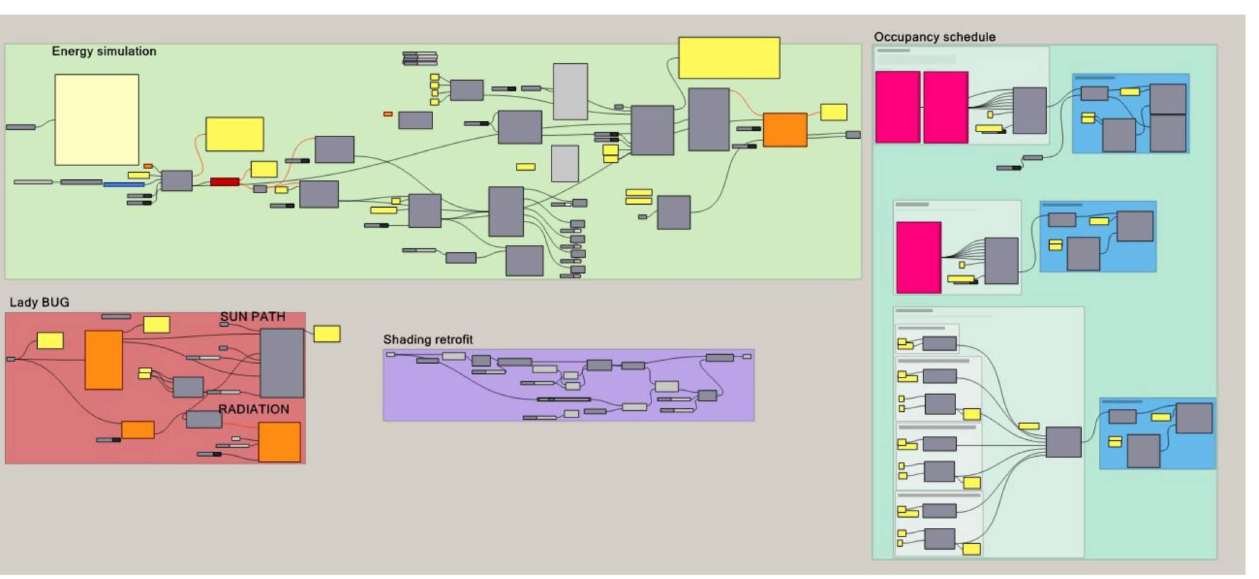
Figure 15. Scripts used for energy calculations, occupancy schedule, and shading